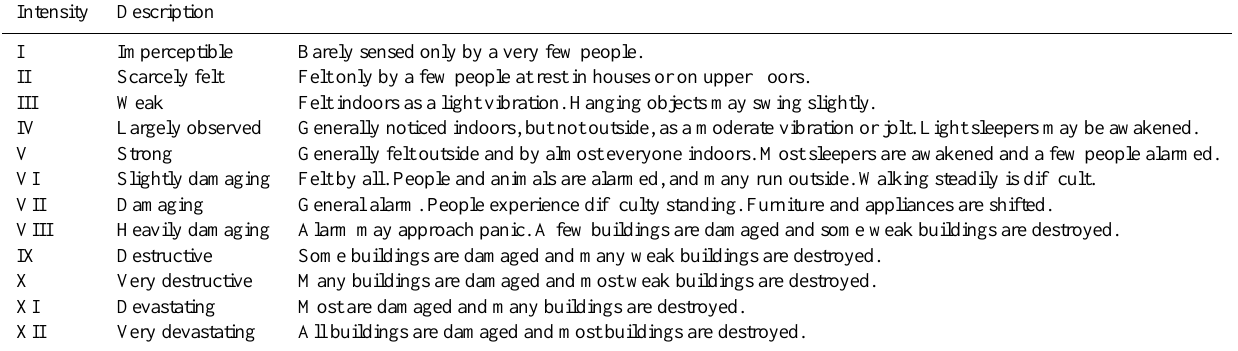
Table 2. The Modified Mercalli Intensity scale (Wood and Neumann, 1931).